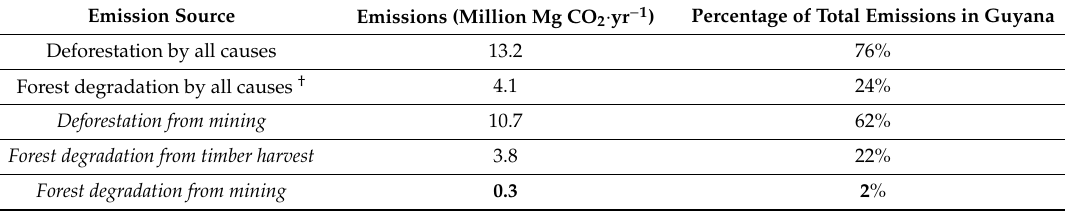
Table 5. Percentage of average annual (over period 2011–2014) greenhouse gas emissions by source in